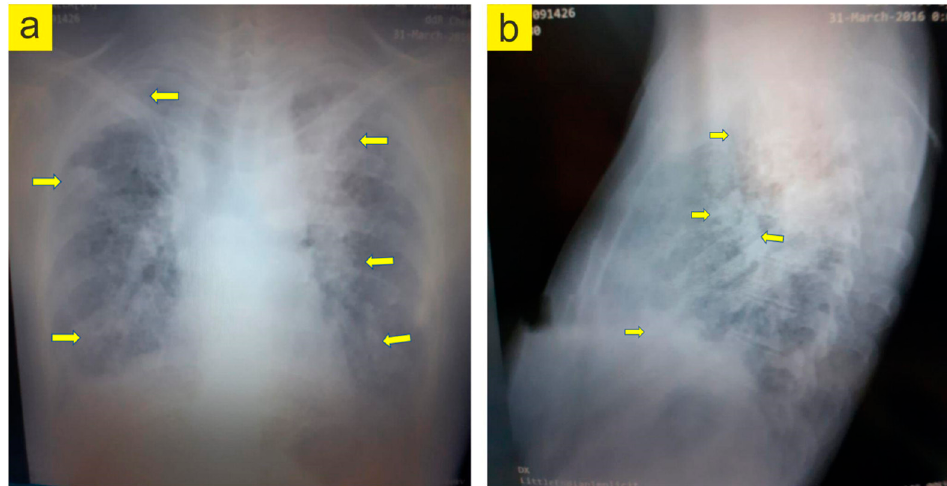
Figure 3. Chest radiography. ( a ). PA lung grapy. ( b ). Lateral lung grapy. Yellow arrows indicate the problem areas. (Images archive of the first author).